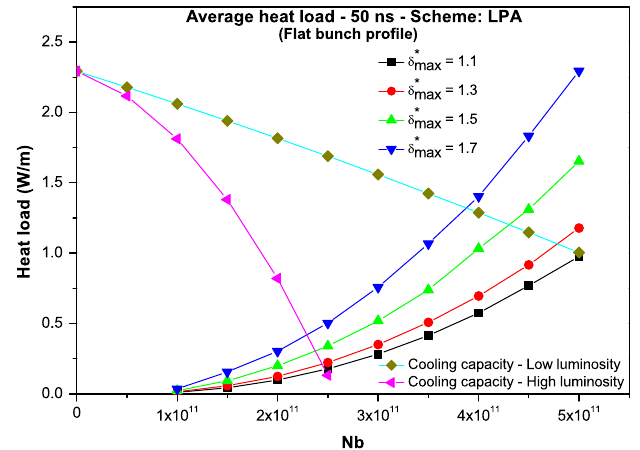
FIG. 12. Average heat load for the simulation set